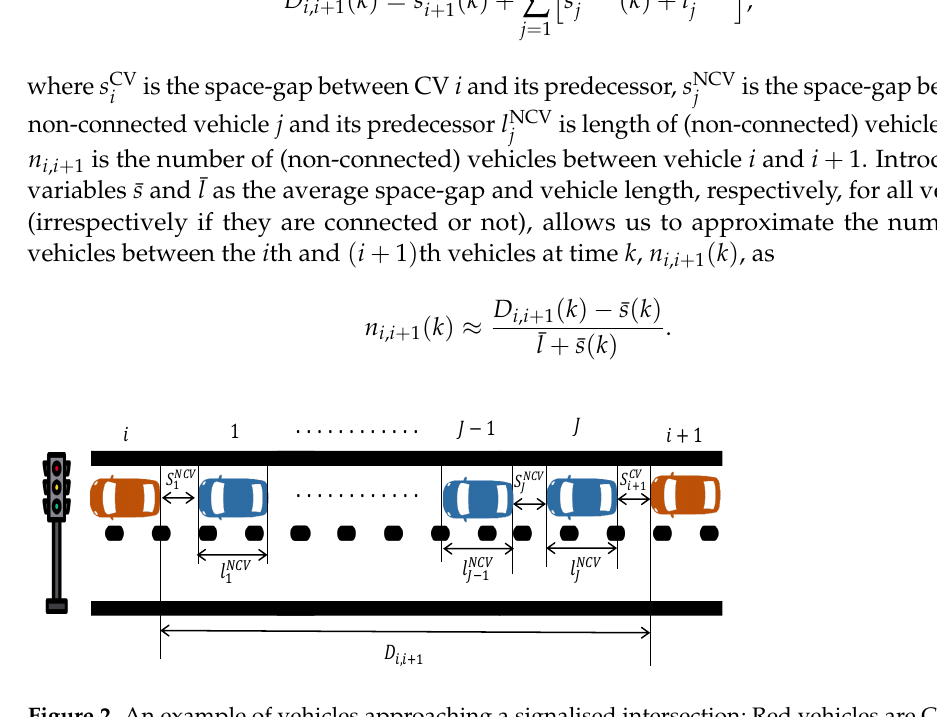
Figure 2. An example of vehicles approaching a signalised intersection; Red vehicles are CVs and blue vehicles are non-connected